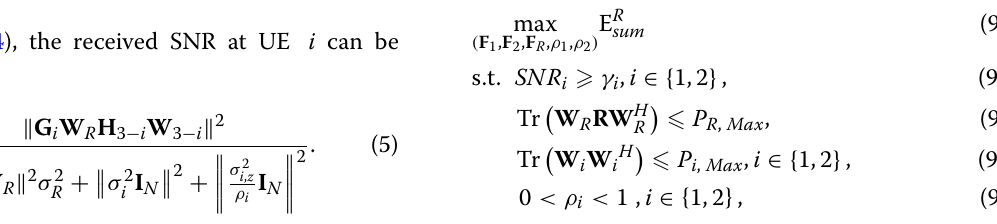
Fig. 1 UAV-enabled two-way relay system with PS-based UEs (cid:3) (cid:2) = P (cid:2) P W R RW RH tr R and P R R , Max , where R + H + σ 2 H H H H H I N , P R and P R , Max H 1 W 1 W H 2 W 2 W R 1 1 2 2 are the realistic transmission power and the limitation of maximum transmission power at UAV relay,